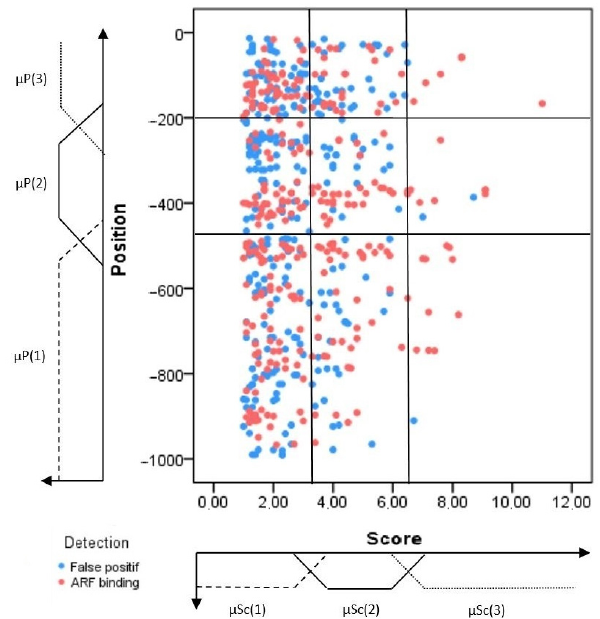
Figure 1. Feature space of the position and significance score representing the training sets distribu- tion of the ARF-binding sites (red color) and false positives (blue color). Three fuzzy sets and their corresponding membership degree functions ( μ Sc(i) and P(j)). The latter parameters were defined for each feature (position and score) and found to yield nine regions. The boundaries of the different sets were determined through a learning step as much as possible to define the discriminative re- gions.